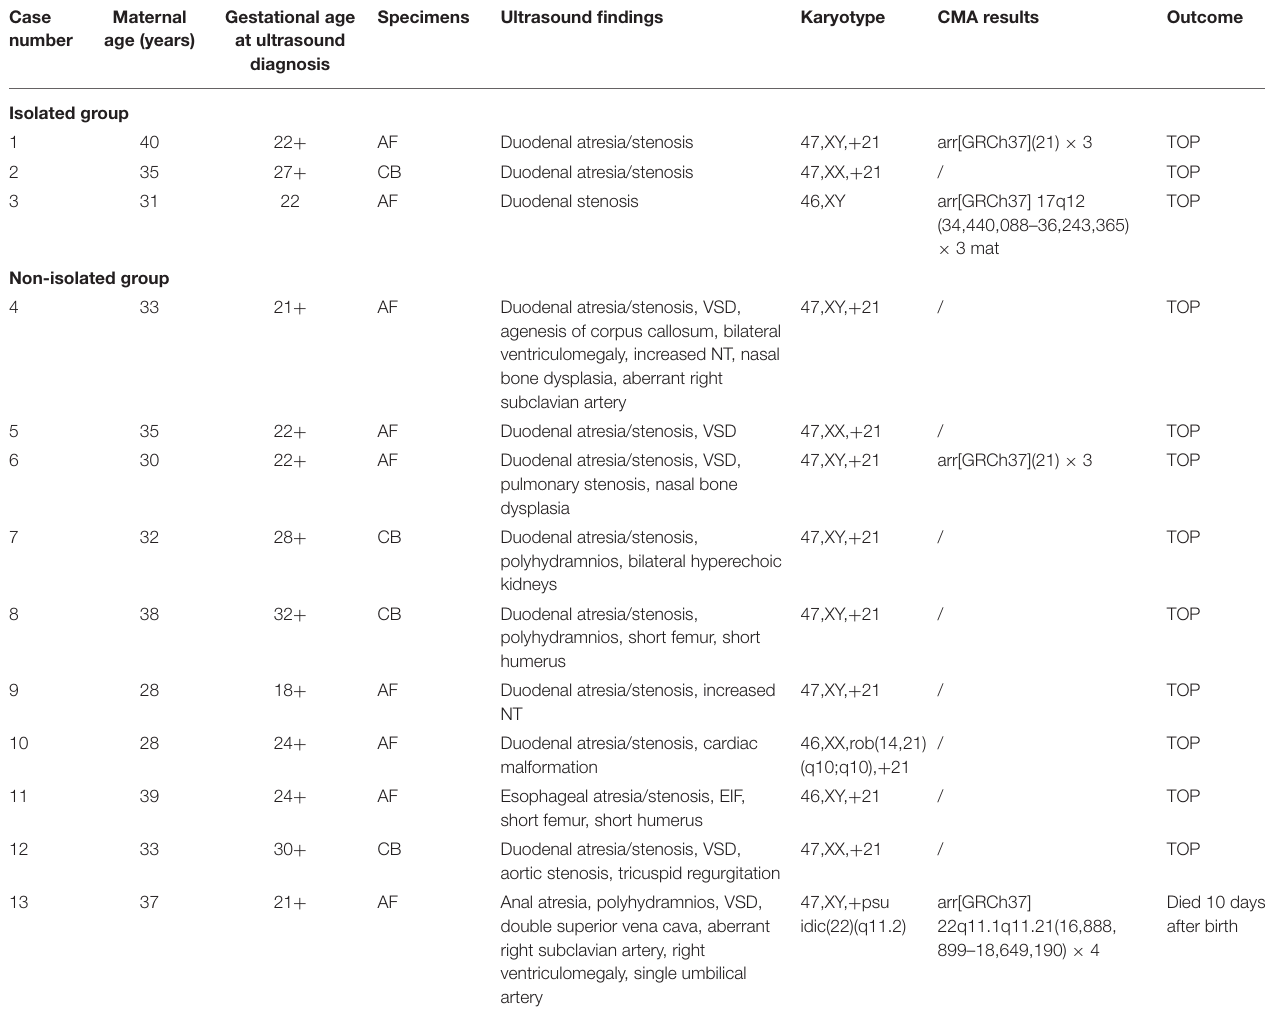
TABLE 2 | Details of 12 abnormal karyotypes and one copy number